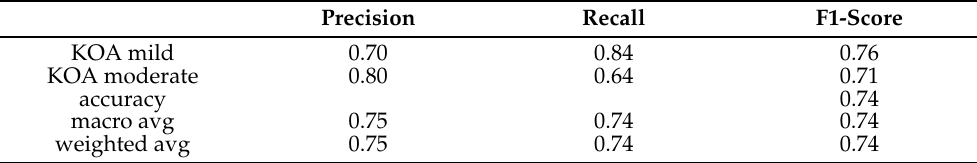
Figure 9. Confusion matrix, accuracy, and loss function for KOA mild vs. moderate. Table 11. Performance metrics KOA mild vs. moderate